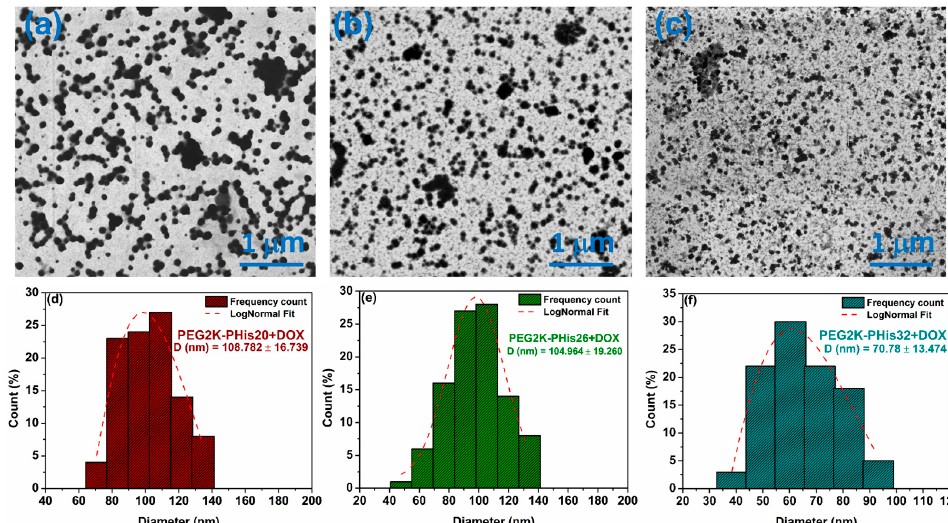
Figure 5. Scanning transmission electron microscopy images of DOX-loaded micelles ( a – c ) and distribution of diameters ( d – f ).